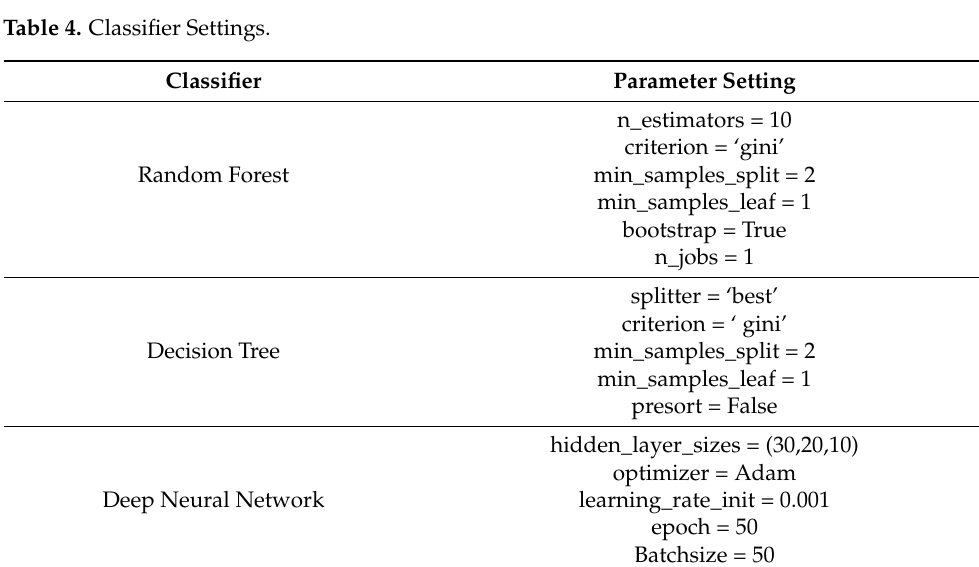
Table 4. Classifier